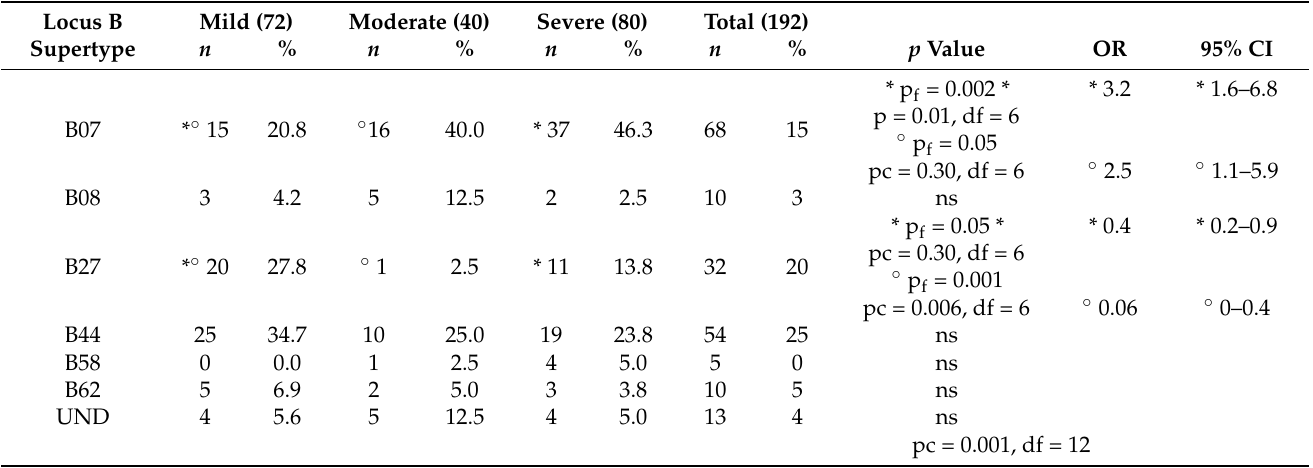
Table 3. Comparison of HLA-B supertype frequencies of 96 Italian patients clustered on the basis of COVID-19 severity classification in line with Chen and colleagues [2].